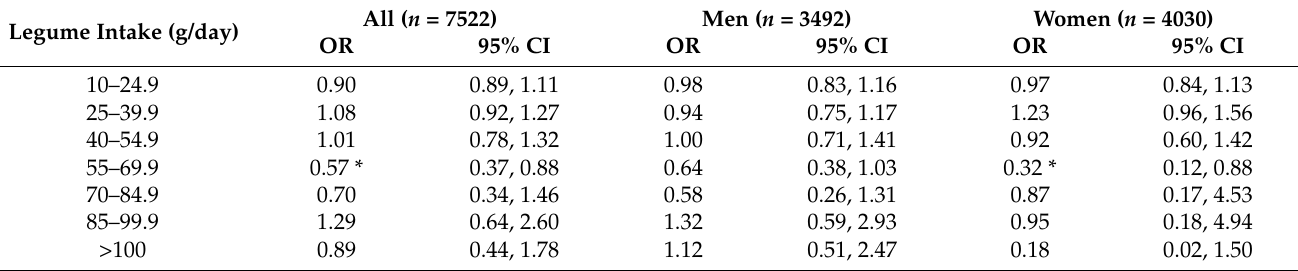
Table 4. Odds of subsequent hypertension compared to the lowest legume consumers (<10 g/day) by daily legume intake range using fully adjusted multivariate model D: odds ratios (OR) and 95% confidence intervals (95%